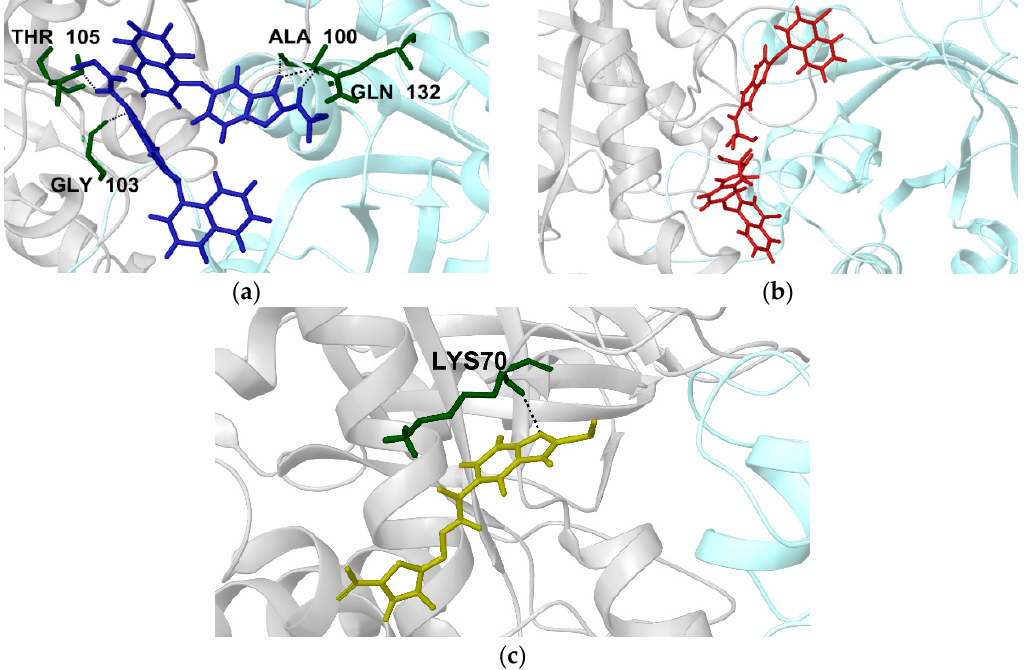
Figure 6. Binding mode of compounds 1 , 2 and 3 on TbTIM (Light Gray ribbons monomer A and Light turquoise ribbons monomer B. ( a ) two molecules of compound 1 (blue sticks); ( b ) two molecules of compound 2 (red sticks); and ( c ) compound 3 (yellow sticks). H-bonds are depicted as dotted lines.